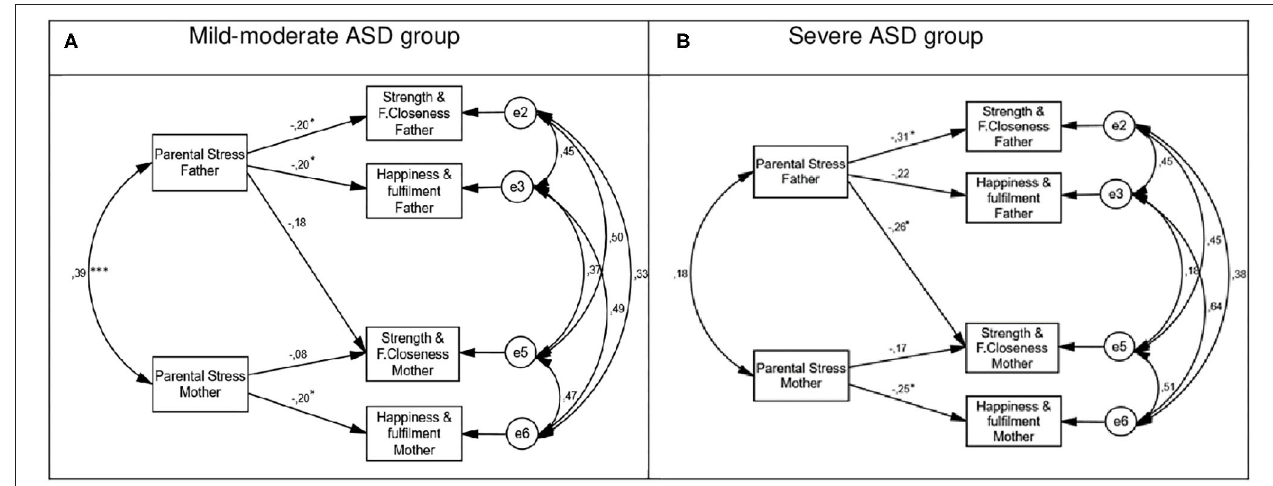
FIGURE 2 | Multigroup parental stress model. (A) Mild moderate ASD group. (B) Severe ASD group. * p < 0.05; *** p < 0.001.